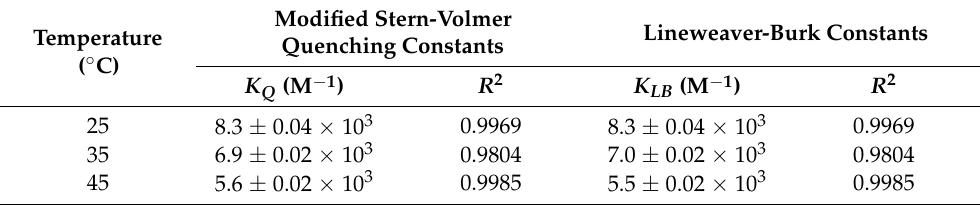
Table 1. Modified Stern-Volmer quenching constants and Lineweaver-Burk constants for the interac- tion of HSA with cuminaldehyde at various temperatures.